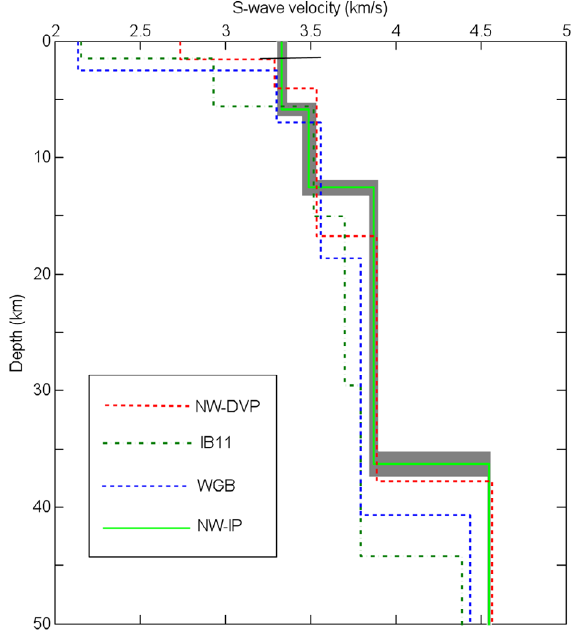
Figure 9. The crust and sub-crustal S -wave velocity ( Vs ) structure of NW-IP (present study) compared with that of the surrounding regions: (1) NW-DVP: North West DVP [Prajapati et al. 2011], (2) IB11: Indus Block [Suresh et al. 2008], (3) WGB: West Ganga Basin [Mitra et al. 2011] and (4) NW-IP (present study). The grey area around the NW-IP model shows its standard deviations in inversion.